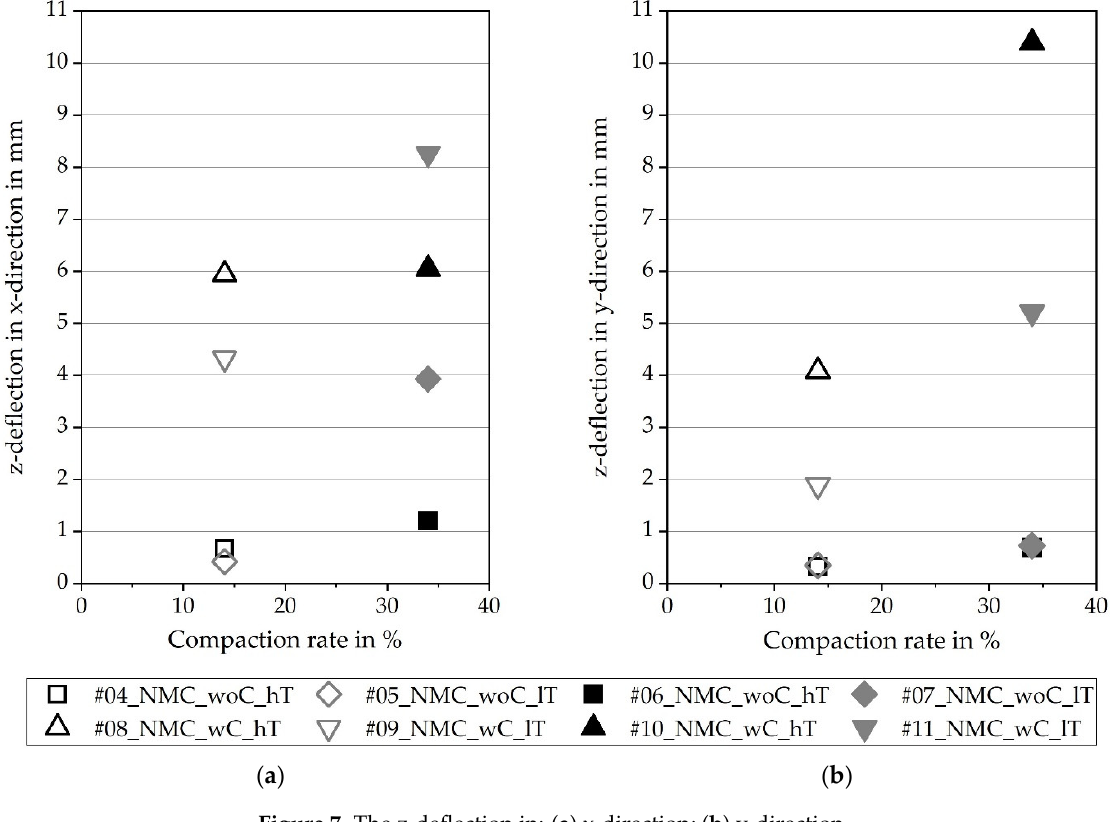
Figure 8. Experiments No. 7 and 11: influence on x-elongation by the uncalendered area (top half) and the uncoated collector (right edge) .